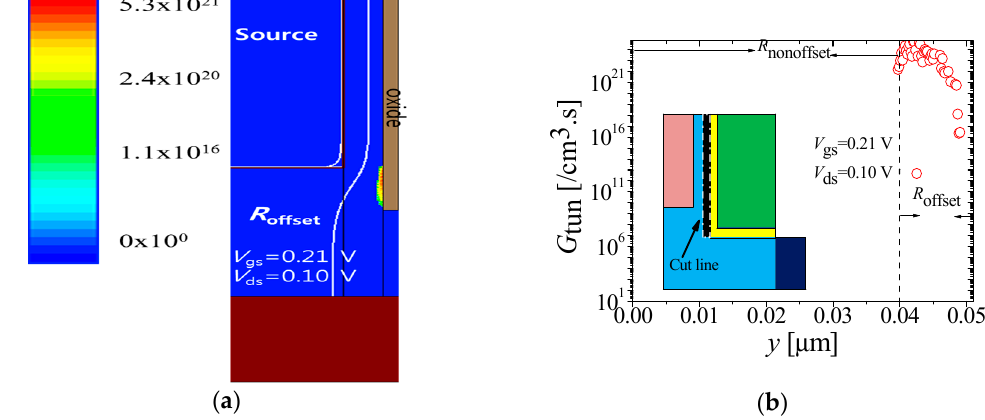
Figure 3. ( a ) G tun contour plot at V gs = 0.21 V, which is the bias needed to generate I ds = 10 − 13 A and ( b ) G tun extracted from ( a ).